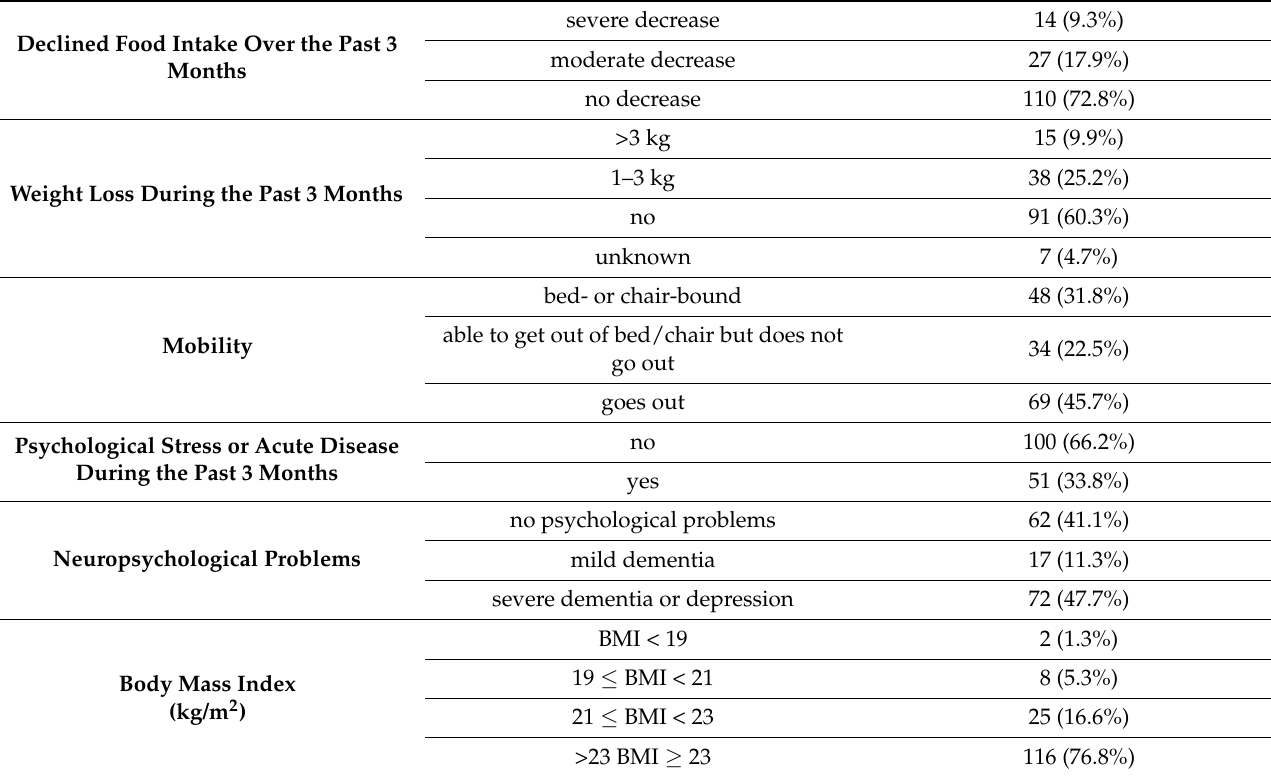
Table 2. Results of the MNA (Mini Nutritional Assessment) screening of the participants ( n = 151). Only the first part (=screening) of the MNA was performed for the